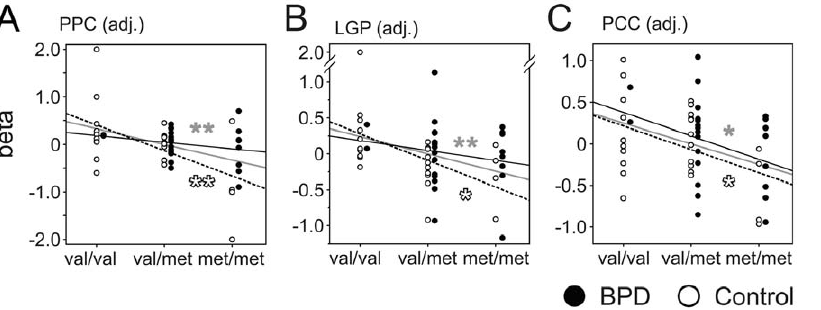
Figure 6. Brain areas activated in response to subjectively adjusted heat pain correlate with COMT val158met polymorphism. During subjectively similar intense heat pain perception (individual temperature in BPD 43 u C in healthy controls), posterior parietal cortex (A), lateral globus pallidus (LGP; B) and the posterior cingulate cortex (PPC; C) displayed significant correlation with COMT-polymorphism. Labelling as in Fig. 2, * p ,